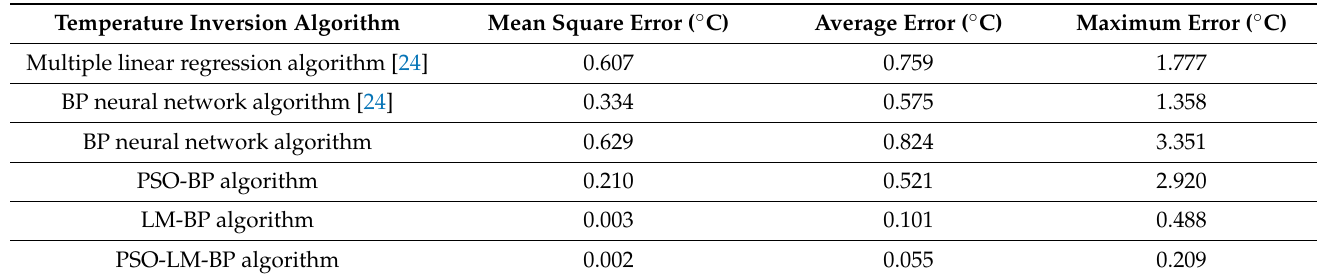
Table 5. Comparison of the temperature inversion algorithm with another correlative microwave